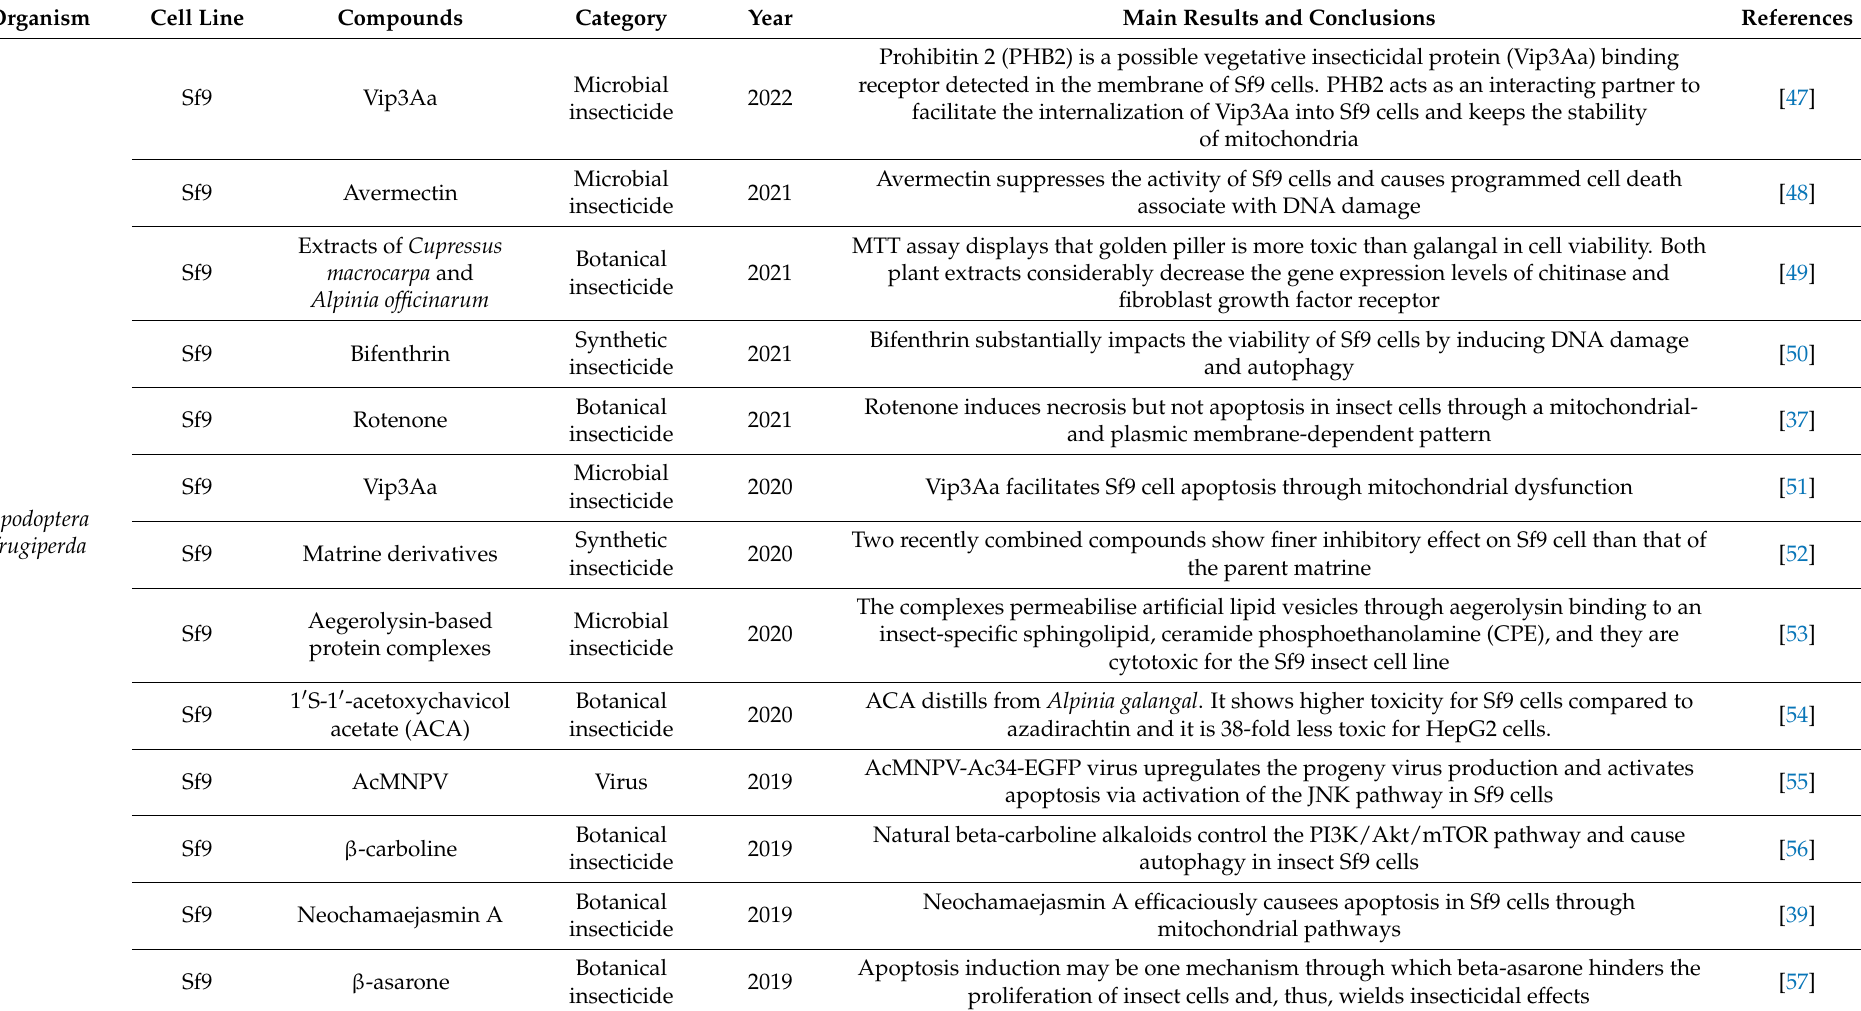
Table 1. The cases of insect cell-based models applied to insecticide cytotoxicology